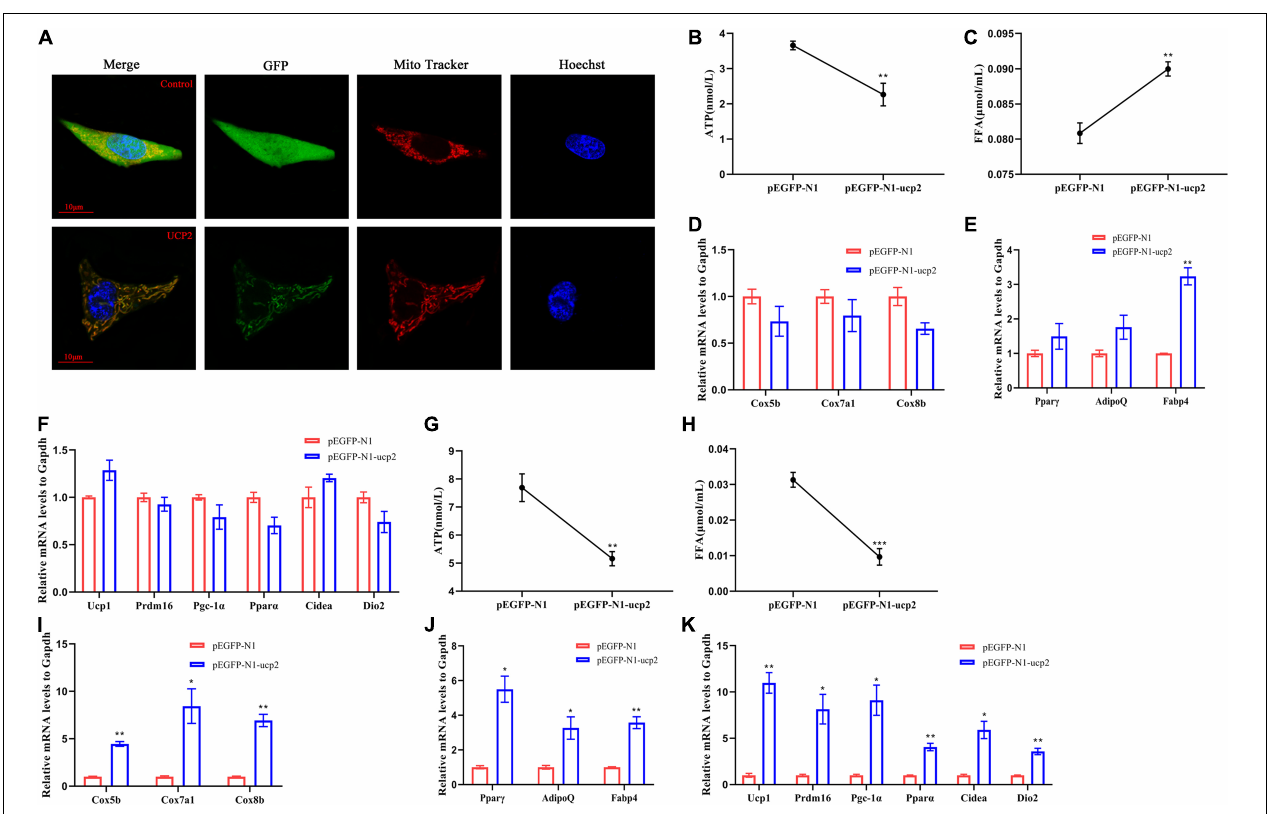
FIGURE 5 | Localization and functional identification of lamprey UCP2 in 3T3L1 cells. (A) The localization of lamprey UCP2 in 3T3L1 cells was observed by confocal microscopy at 30 h after UCP2 overexpression in 3T3L1 cells. (B,C) ATP content and FFA content of 3T3L1 cells overexpressing UCP2. (D–F) mRNA levels of mitochondrial genes (D) , general adipocyte markers (E) , and brown-selective genes (F) after overexpression of UCP2 in 3T3L1 cells ( n = 3). (G,H) ATP content and FFA content of mature brown adipocytes overexpressing UCP2. (I–K) mRNA levels of mitochondrial genes (I) , general adipocyte markers (J) , and brown-selective genes (K) in mature brown adipocytes overexpressing UCP2 ( n = 3). All expression data are presented as the mean ± SD; * P < 0.05; ** P < 0.01; *** P <